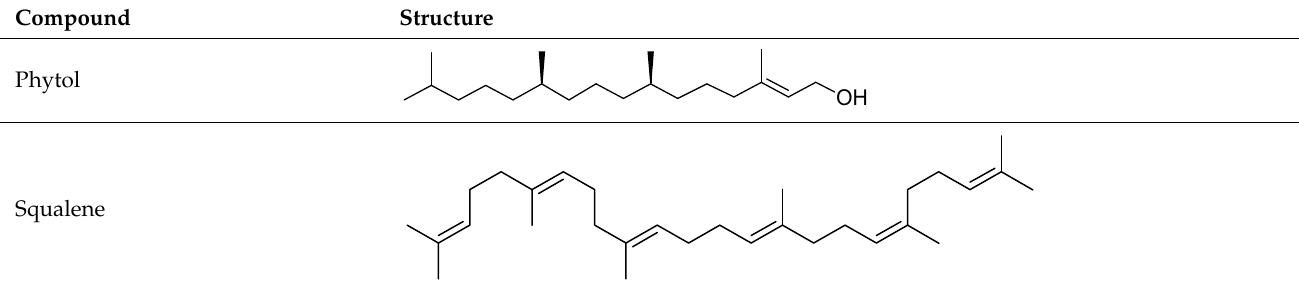
Table 2. Structure of the identified components of Sterculia diversifolia plant ethanolic extract. Figure 1. Green synthesis of AgEPE; size observed by SEM at 30 kV and 200,000× magnification.